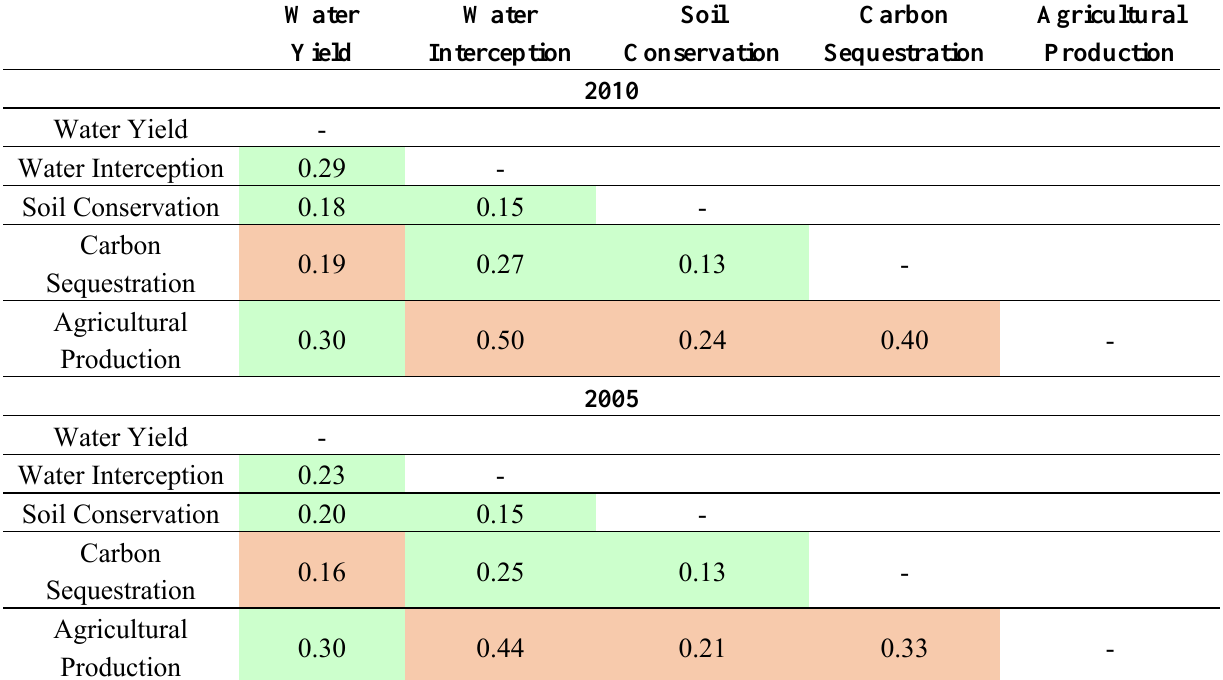
Figure 6. Flower diagrams. Reveals the normalized value of each ecosystem service through petal length, each flower represents one land-use type in a certain year. Table 2. Index of synergies and trade-offs among ecosystem services (green blanks for synergies and orange for